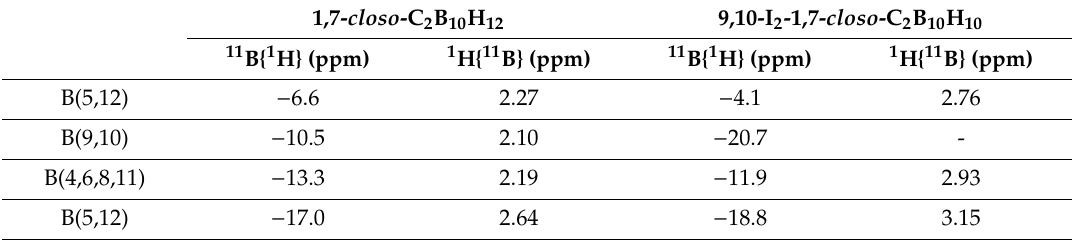
Table 2. The 11 B{ 1 H} and 1 H{ 11 B} chemical shifts of icosahedral compounds 1 and 2 . Spectra were recorded in (CD 3 ) 2 CO. See Figure 1 for vertexes